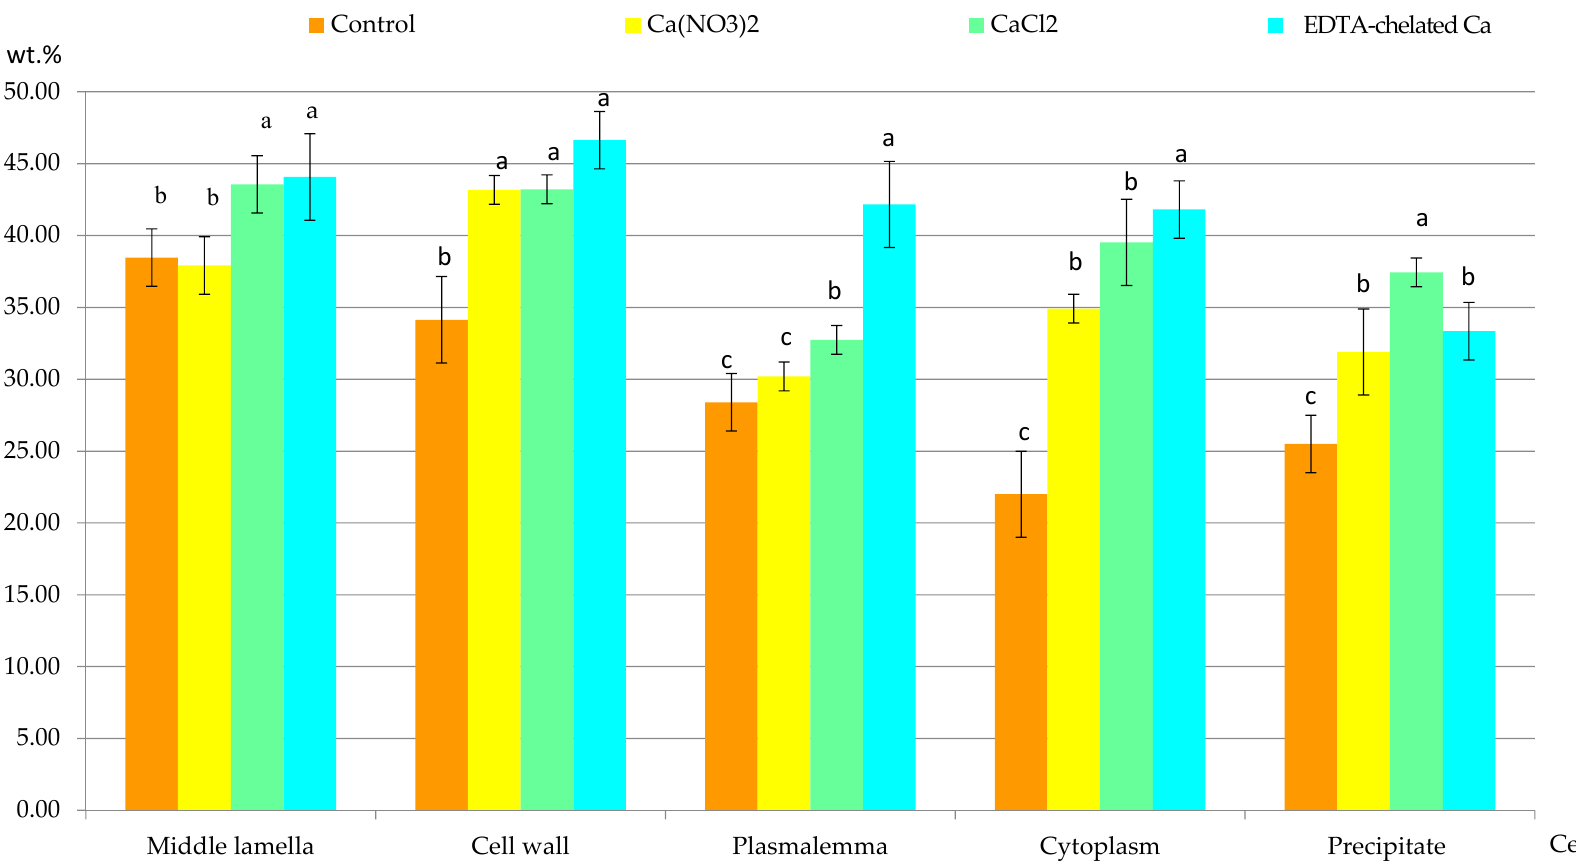
Figure 8. Content of Ca 2+ ions in selected epidermis cell elements and precipitates (calcium oxalate crystals) in the apical part of ‘Szampion’ apples . Means (±SD) for each of cell element marked with different letter above the bars are significantly different at p ≤ 0.05.